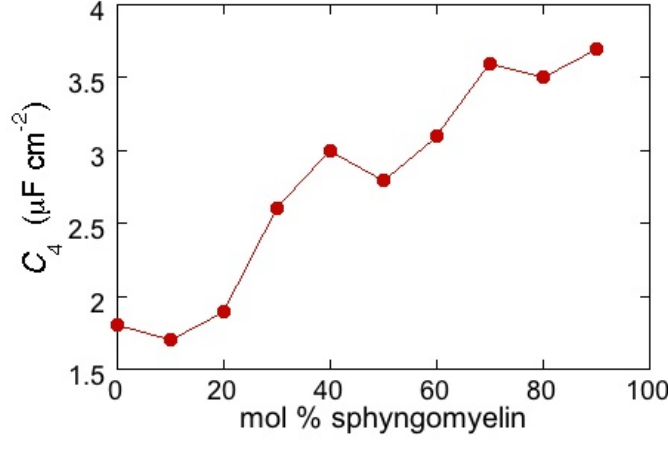
Figure 5. Plot of the capacitance C of the hydrocarbon tail region for a Hg-supported 4 DOPC/PSM (50:50) monolayer in aqueous 0.1 M KCl at − 0.55 V, as a function of mol%